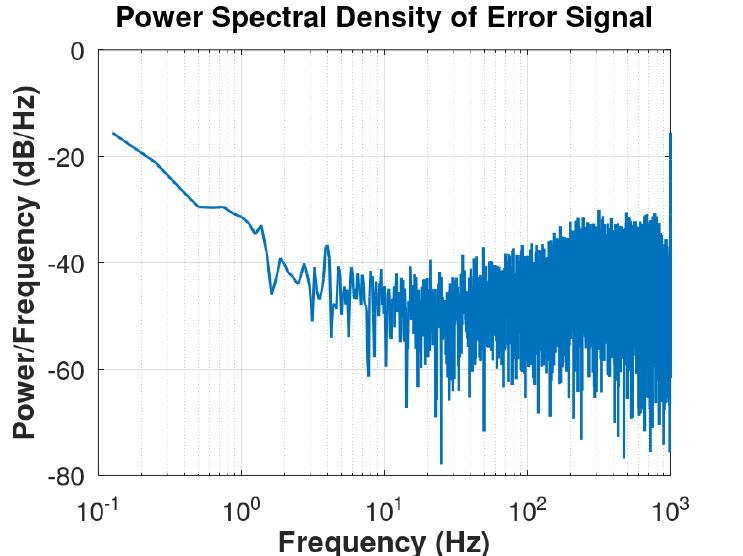
Figure 9. Behavior of the power spectral density (PSD) of the error signal by